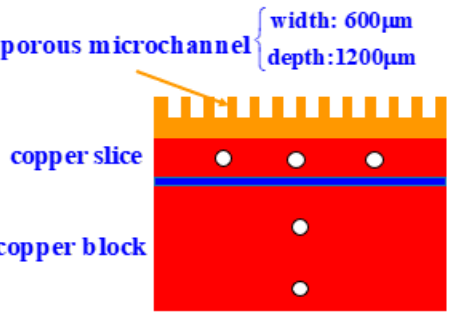
Figure 3. Microchannel test section: ( a ) Microchannel test section; ( b ) Copper block; ( c ) Porous microchannel.